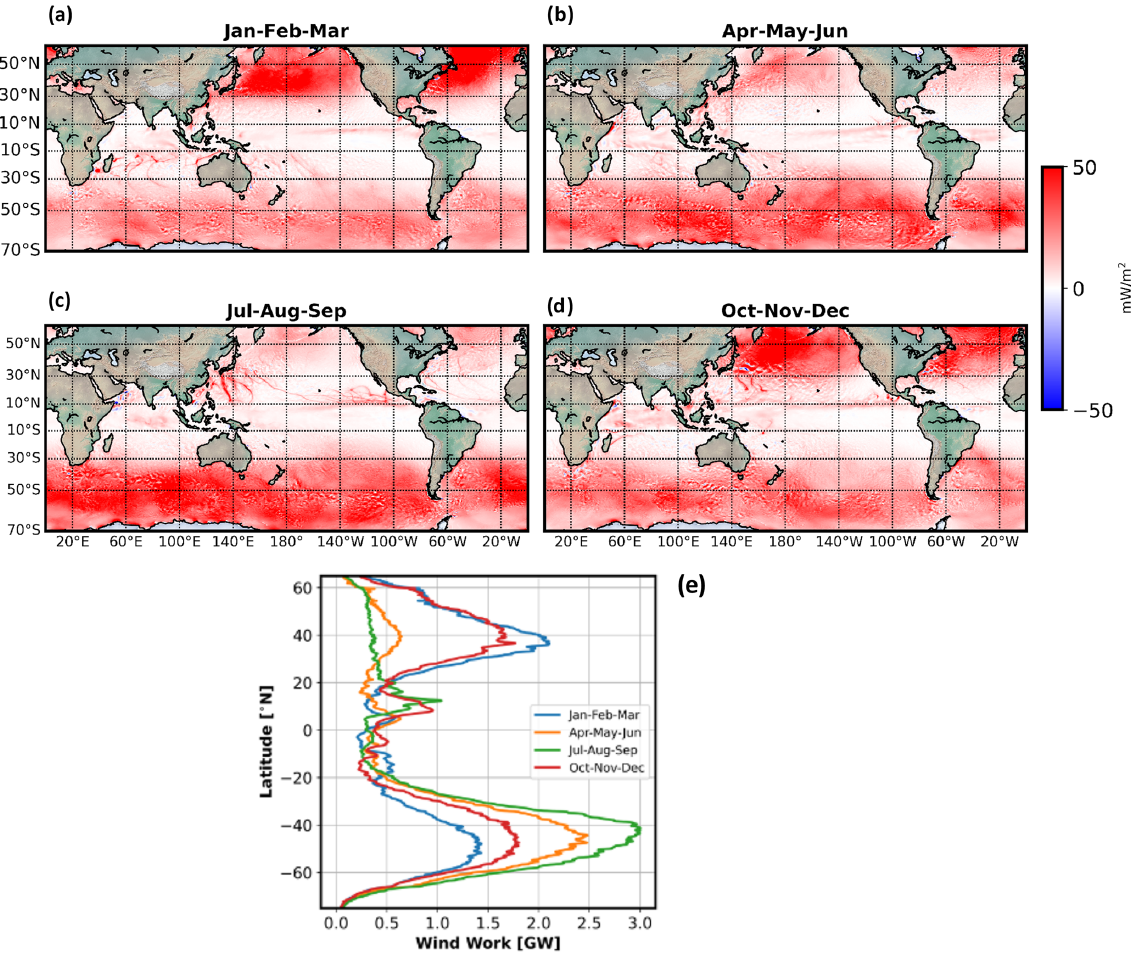
Figure 5. (a–d) Time-dependent component of the wind work, τ (cid:48) . u (cid:48) o , in different seasons. (e) Wind work multiplied by the area of the numerical grid cell (m 2 ) and zonally integrated during the four